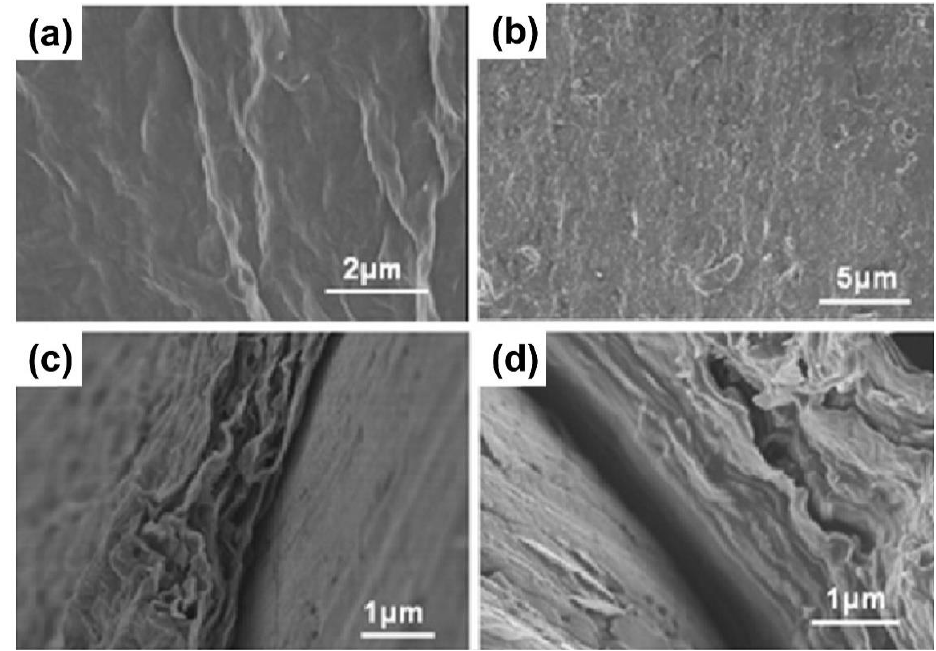
Figure 5. ( a ) Top and ( b ) cross-section SEM image of the graphene-based fiber electrode by chemical reduction; ( c ) Top and ( d ) cross-section SEM image of the graphene-based fiber electrode by thermal reduction [114] (copyright permission Wiley-VCH 2020).